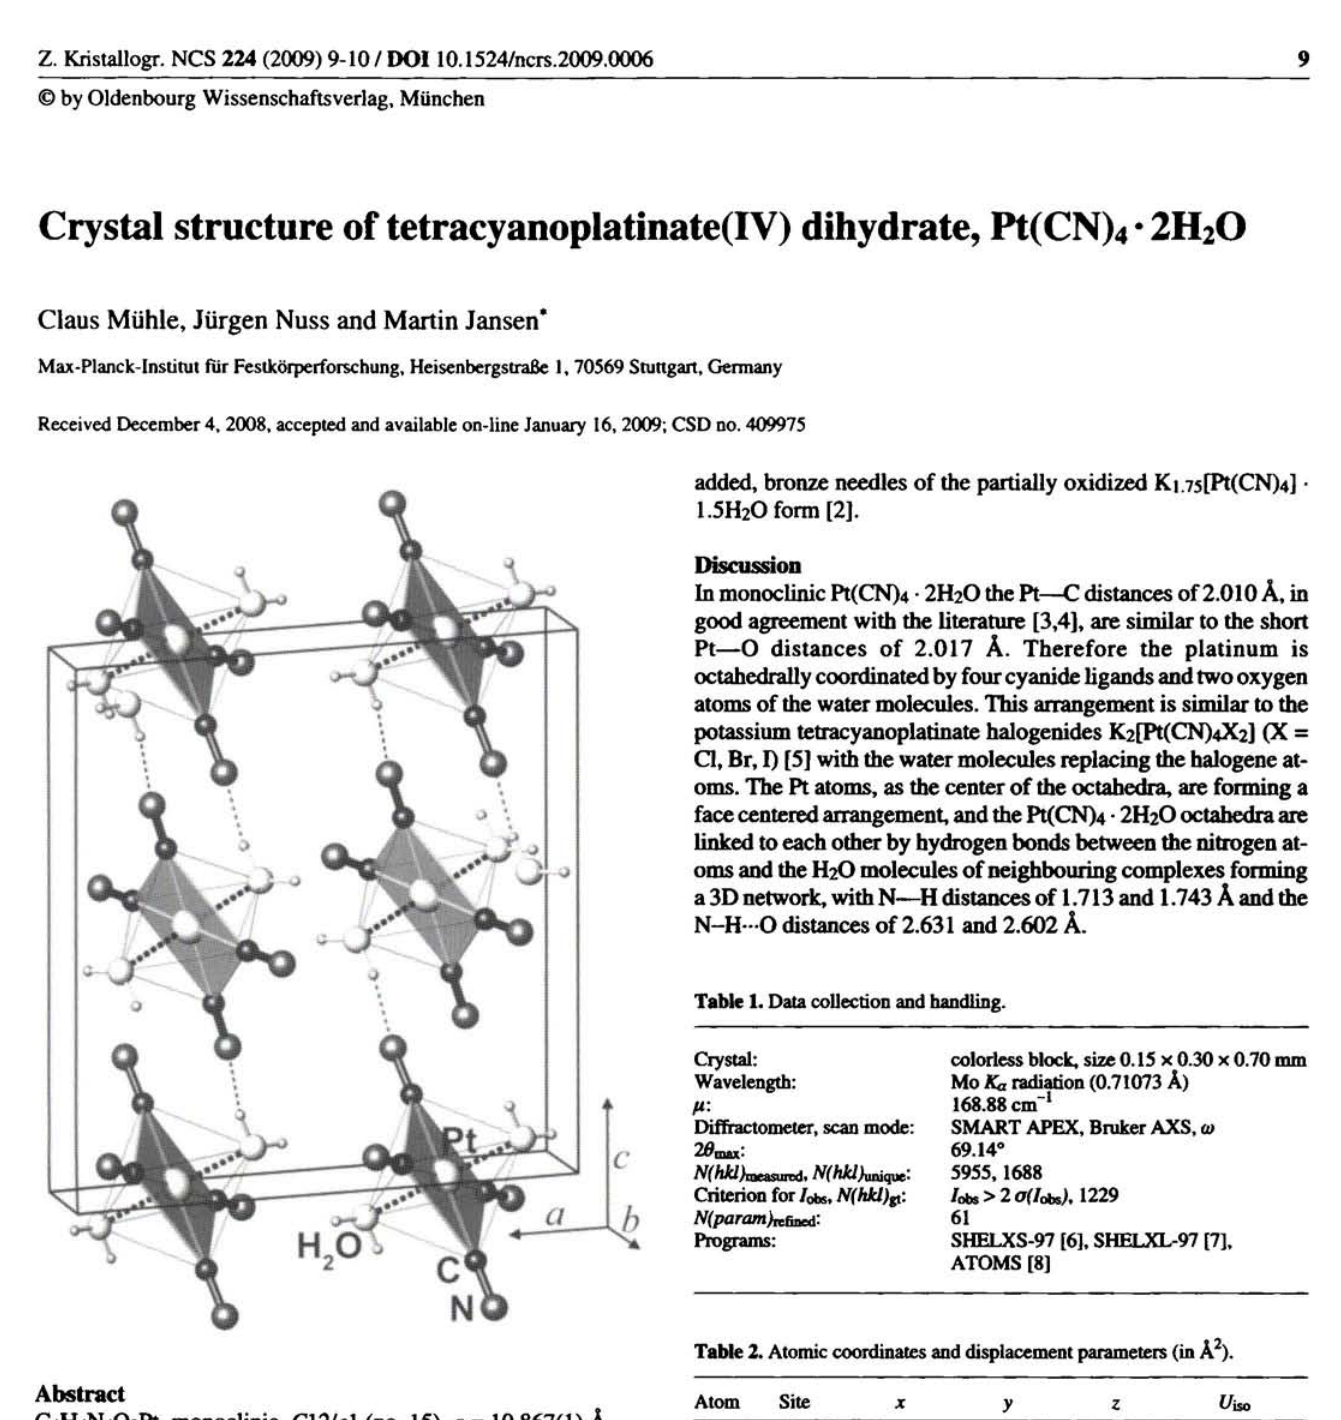
Table 2. Atomic coordinates and displacement parameters (in Â 2